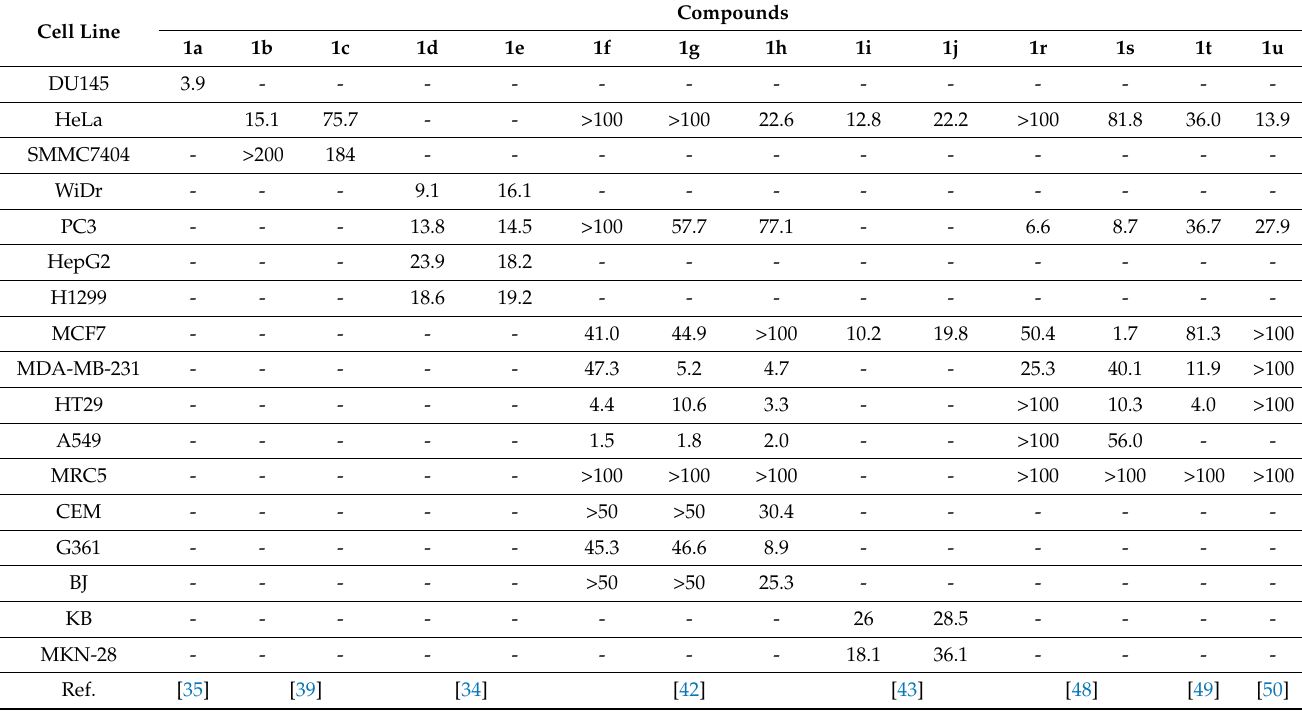
Table 1. IC 50 values ( µ M) of the synthesized androstane oxime